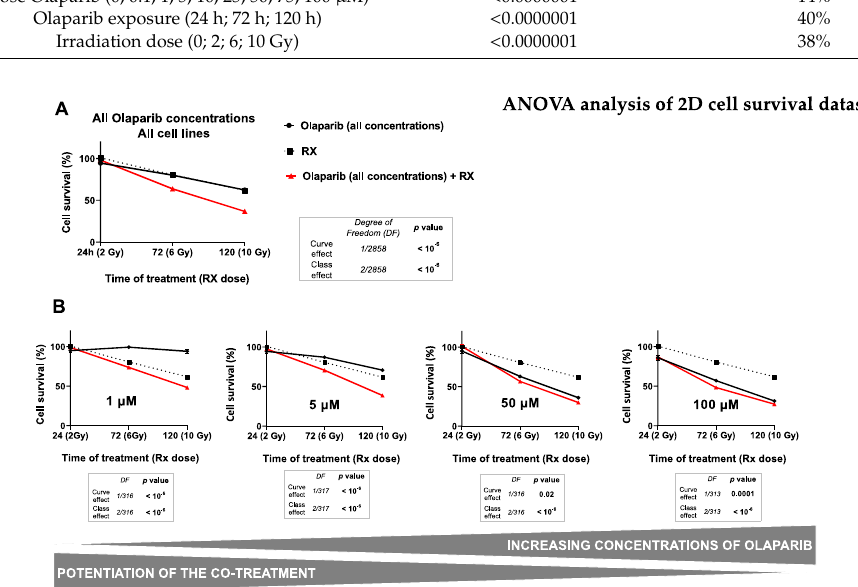
Figure 2. ANOVA analysis of monolayer cell culture sensitivity (SRB survival test) after the co-treatment: The graph ( A ) describes the decrease in the cell survival of both cell lines (MDA-MB-231 and SUM1315) by the time, according to (i) the Olaparib treatment alone (all concentrations), (ii) the treatment with fractioned irradiation alone or (iii) the co-treatment with Olaparib (all concentrations) and fractioned irradiation. The second set of graphs ( B ) describes the decrease of cell survival of both cell lines by the time according to (i) the Olaparib treatment alone after each concentration of 1 µ M, 5 µ M, 50 µ M or 100 µ M and (ii) the co-treatment Olaparib (same concentrations) with fractioned irradiation. For A and B , the curve e ff ect ( = significant decrease in cell survival by the time for a same condition) and the class e ff ect ( = significant di ff erence in cell survival for a same incubation time between each condition) were determined by the ANOVA analysis, associated with their degree of freedom ( = number of data of each